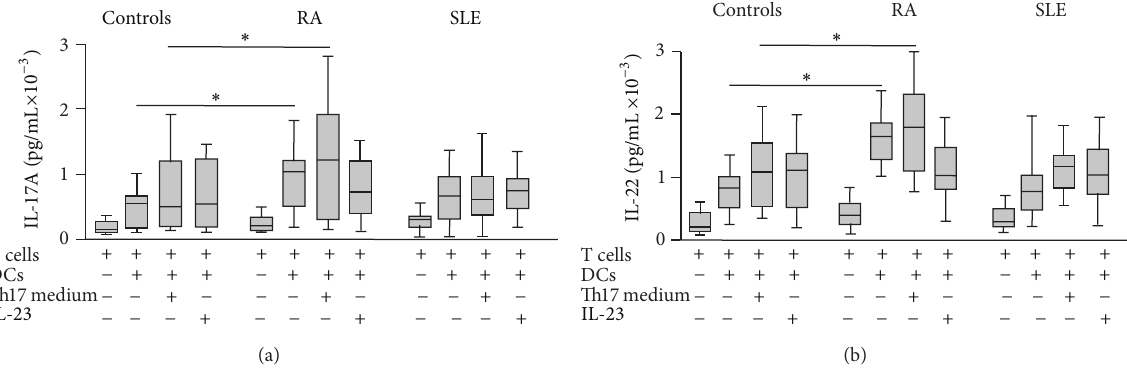
Figure4:Th17cytokinesynthesisbycoculturesofDCsandCD4+lymphocytesinpatientswithRAandSLE.IL-17AandIL-22werequantified in the supernatants of the cell cultures shown in Figure 3. Data correspond to the median and interquartile range of cytokine concentration. ∗ 𝑃 < 0.05